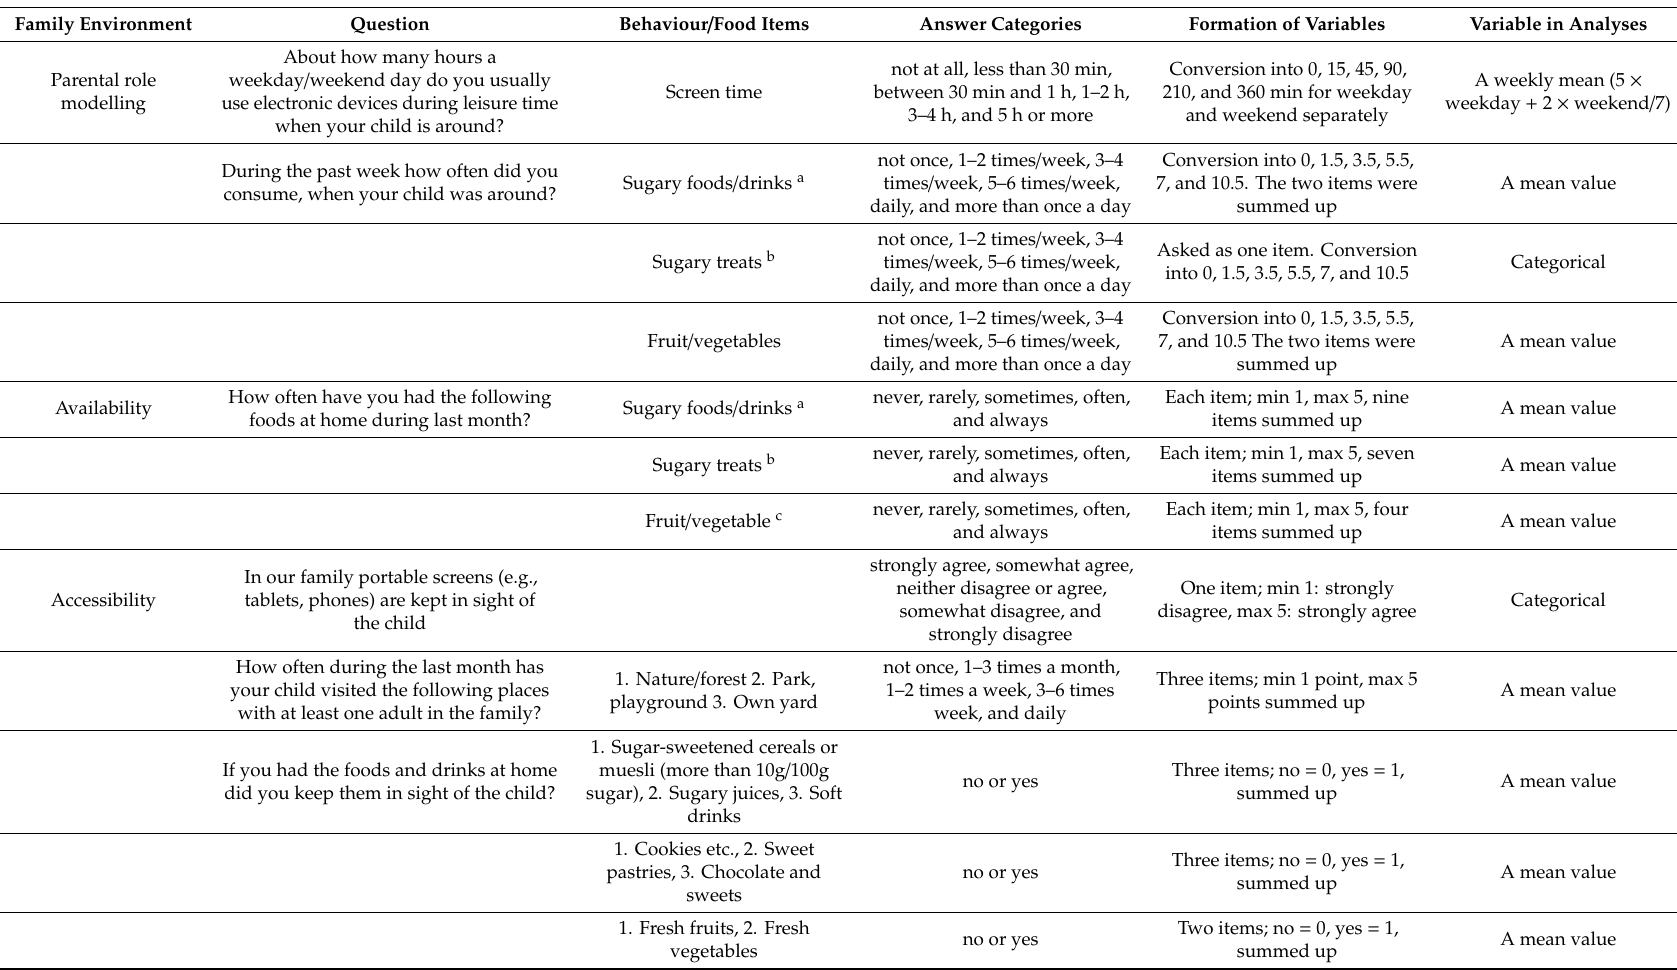
Table 1. Questions on parental role modelling, availability, and accessibility, answer categories, and the formation of the variables used in analyses. Family